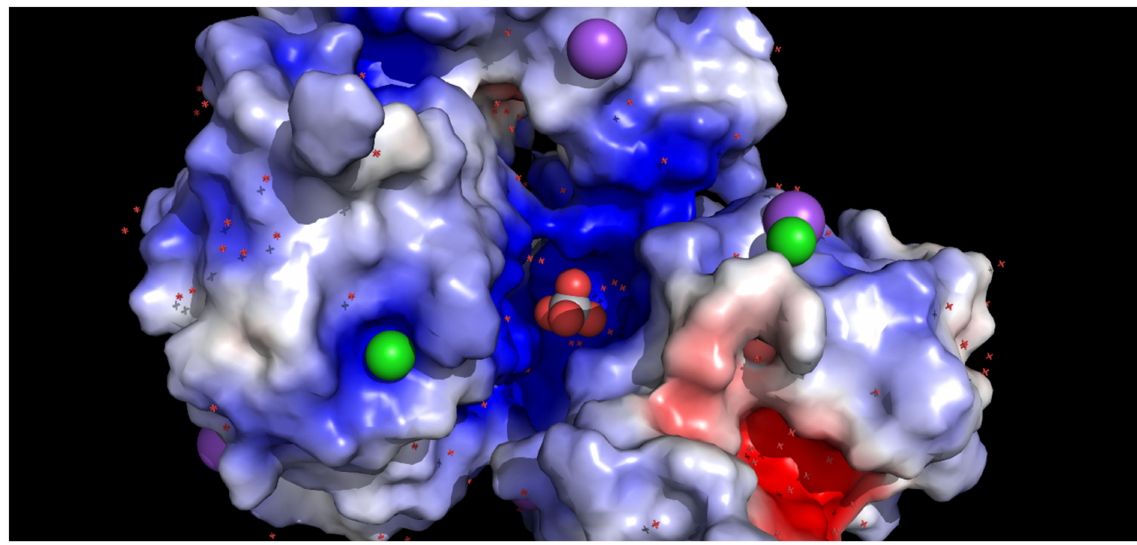
Figure 2. Surface representation (calculated with PyMOL APBS plugin) of the environment in which the titanium species is found, colored by electrostatic potential showing chloride ions in green and sodium in